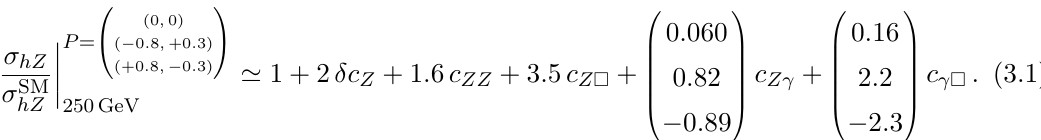
Figure 2 . De(cid:12)nition of the (cid:10) = Note the two polar angles are respectively de(cid:12)ned in the center-of-mass and Z